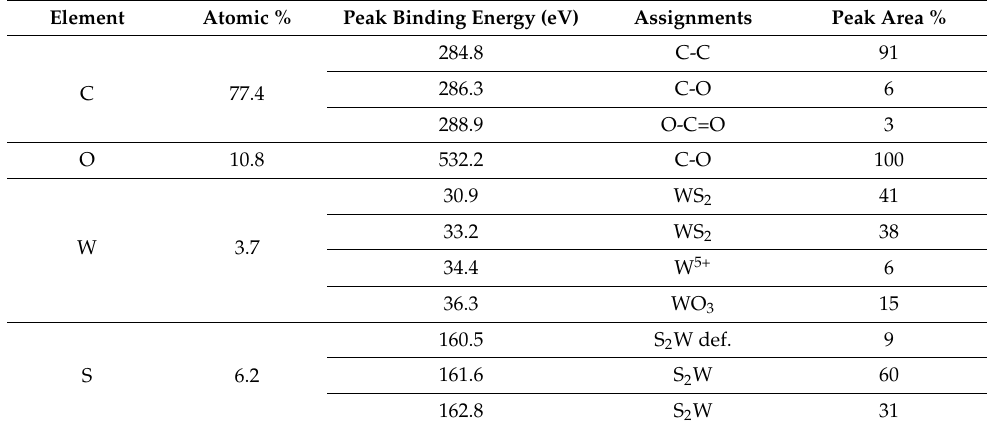
Figure 3. XPS survey spectrum of WS 2 nanoflowers. Table 1. Summary of the atomic composition stoichiometric assignments obtained from the fitting of the XPS spectra of WS 2